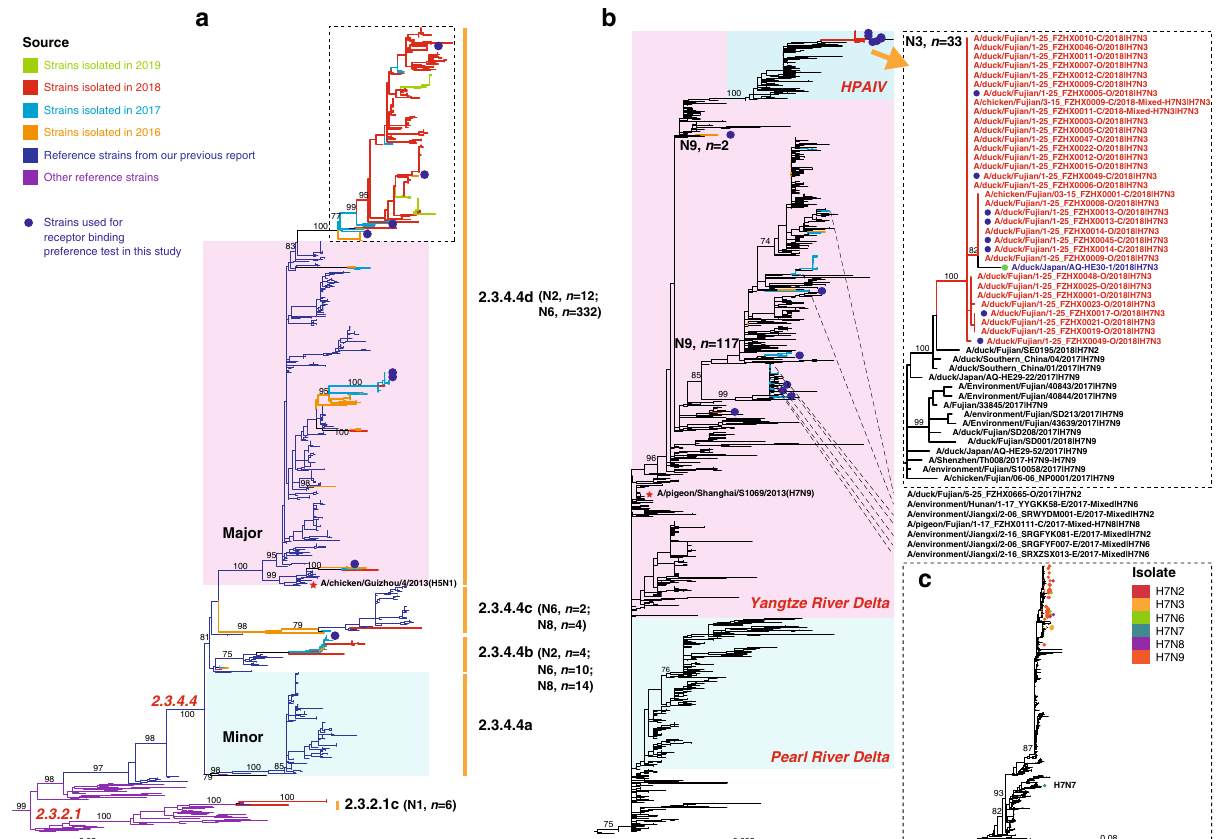
Fig. 4 Phylogenetic analysis of the HA gene sequences of H5 and H7 AIVs. a Phylogenetic tree of the HA gene of H5 AIVs. The orange, light blue, red, and light green lines in the tree represent viruses described in this study isolated from 2016, 2017, 2018, and 2019, respectively. The dark blue lines represent the reference strains previously reported by Bi et al. 13 . The subtrees marked with a pink and light blue background represent the major lineage (Clade 2.3.4.4d) and the minor lineage (Clade 2.3.4.4a), respectively. The purple lines represent other reference strains from the In fl uenza Virus Resource at NCBI and the GISAID databases. b Phylogenetic tree of the HA gene of H7 AIVs. The subtrees marked with a pink and light blue background represent H7 strains belonging to the Yangtze River Delta lineage and Pearl River Delta lineage, respectively. The subtree of the H7N9 HPAIVs previously analyzed by Quan et al. 23 is marked with the blue background on the upper right. The orange, light blue, and red lines of the tree represent strains isolated from 2016, 2017, and 2018, respectively. The subtree displayed in the dashed frame on the upper right included the HA genes of 33 H7N3 isolates in this study. The dotted lines represent H7N2 ( n = 3), H7N6 ( n = 3), and H7N8 ( n = 1) viruses identi fi ed in this study. c The topology of the HA tree of H7 AIVs was shown at the bottom-right, with dots represent 160 H7 AIV strains identi fi ed in our surveillance during 2016 – 19. All blue dots in the phylogenetic trees ( a , b ) represent the H5 and H7 strains used for receptor-binding test in this study. In addition, the red pentagrams represent the H5/H7 bivalent vaccine strains, A/chicken/Guizhou/4/2013(H5N1) and A/pigeon/Shanghai/S1069/2013(H7N9),